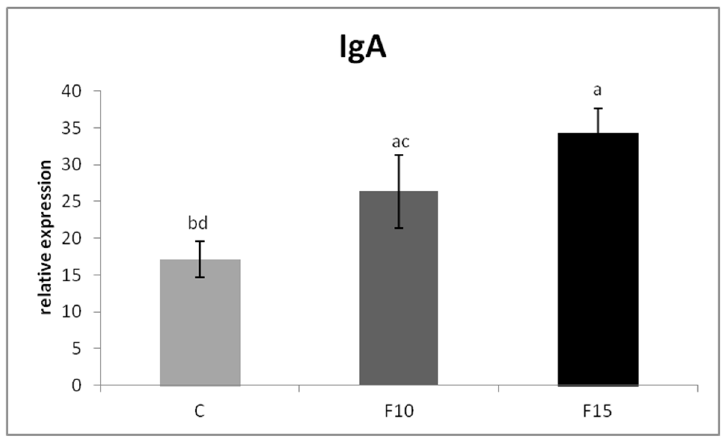
Figure 2. Relative expression of IgA gene in cecum of laying hens treated with fermented feed. Re- sults at each time point are the median of 2 – Δ Cq . Means with different superscripts are significantly different ab p < 0.05; ac p < 0.01; ad p < 0.001.